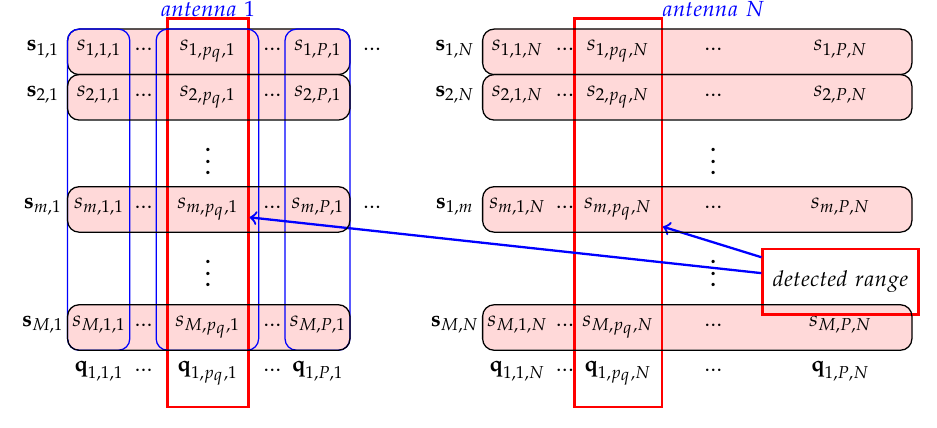
( q ) ( q ) from FFT matrix for detected range p q from FFT matrix for detected range p q l , p q , n l , p q , n and l = 1